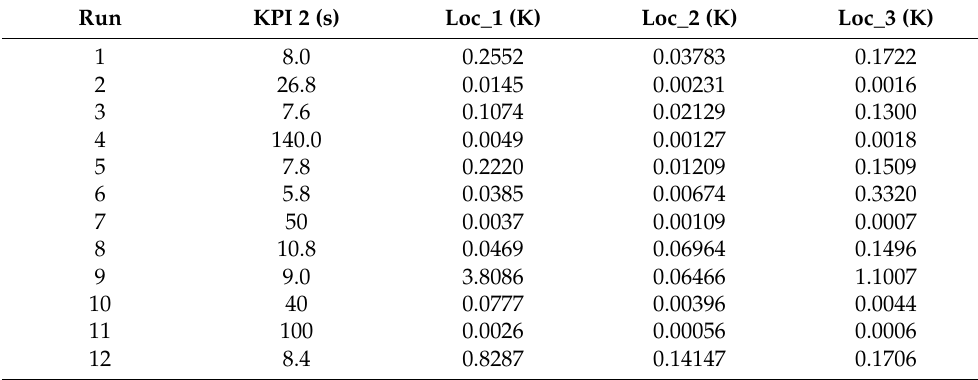
Table 11. Results of the average granular temperature over the length of the paddle mixer. The three different locations are the fluidized zone (Loc_1) and at the bottom left (Loc_2) and bottom right (Loc_3). See Figure 4 for the definition of the locations Loc_1, Loc_2 and Loc_3. Run KPI 2 (s) Loc_1 (K) Loc_2 (K) Loc_3 (K) 1 8.0 0.2552 0.03783 0.1722 2 26.8 0.0145 0.00231 0.0016 3 7.6 0.1074 0.02129 0.1300 4 140.0 0.0049 0.00127 0.0018 5 7.8 0.2220 0.01209 0.1509 6 5.8 0.0385 0.00674 0.3320 7 50 0.0037 0.00109 0.0007 8 10.8 0.0469 0.06964 0.1496 9 9.0 3.8086 0.0044 11 100 0.0026 0.00056 0.0006 12 8.4 0.8287 0.14147